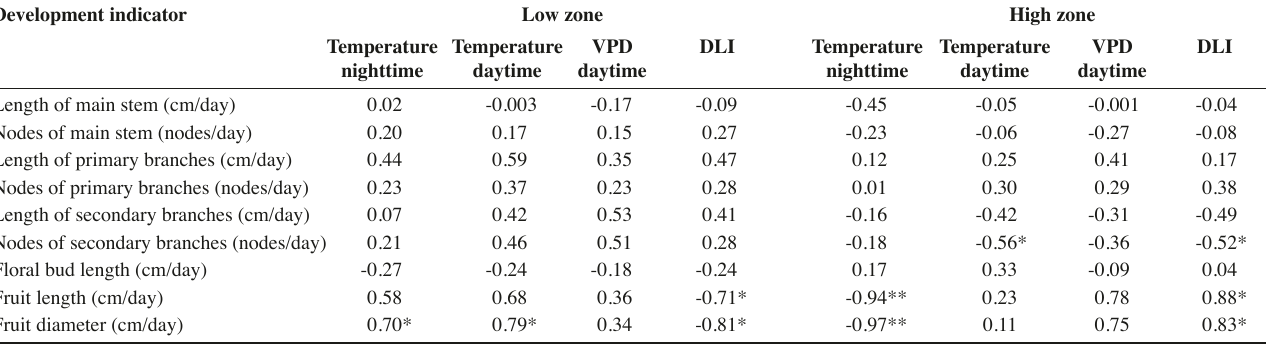
Tab. 2: Matrix of correlations between phenological development indicators and climatic variables evaluated in P. tripartita var. mollissima in a high zone (2,498 m.a.s.l.) and a low zone (2,006 m.a.s.l.) in the municipality of Pasca (Cundinamarca, Colombia). The number in each box indicates Spearman’s correlation coefficient and * the level of significance: * p≤0.05, ** p<0.01.